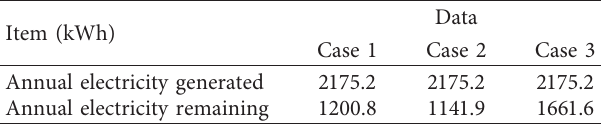
Table 9: The simulation results of energy flow of three